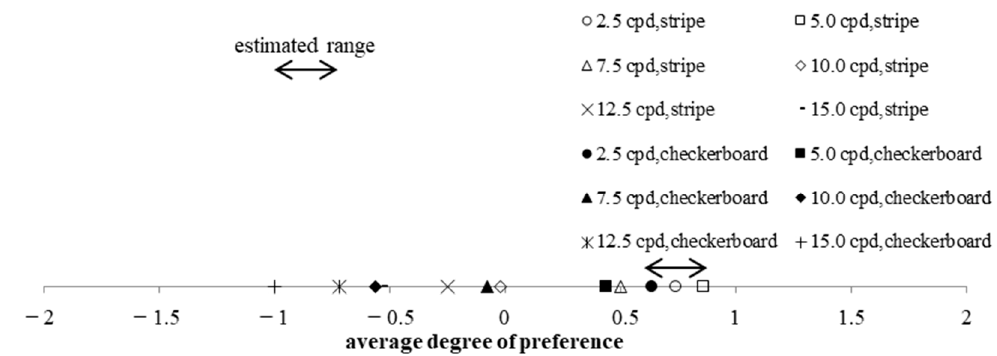
Figure 6. In terms of spatial frequency conspicuity between the stripes and checkerboard patterns, the 5.0 cpd stripes were the most conspicuous results. There was no significant difference between the 5.0 cpd stripes and the 2.5 cpd stripes, and the 2.5 cpd checkerboard pattern.